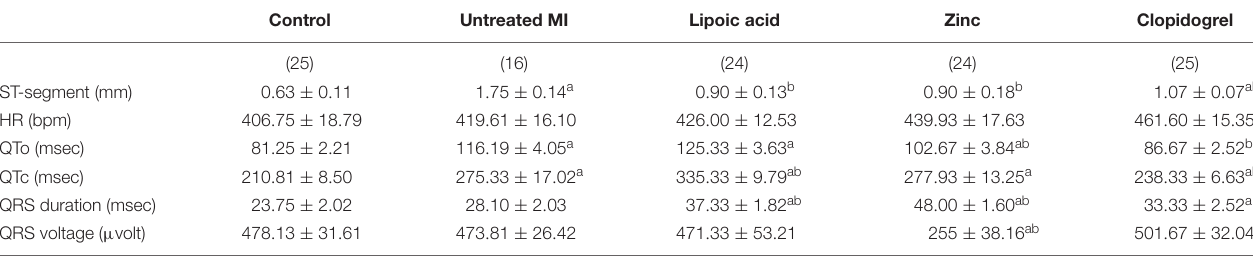
TABLE 2 | Electrocardiographic parameters of the control, untreated MI, and pre-treated MI